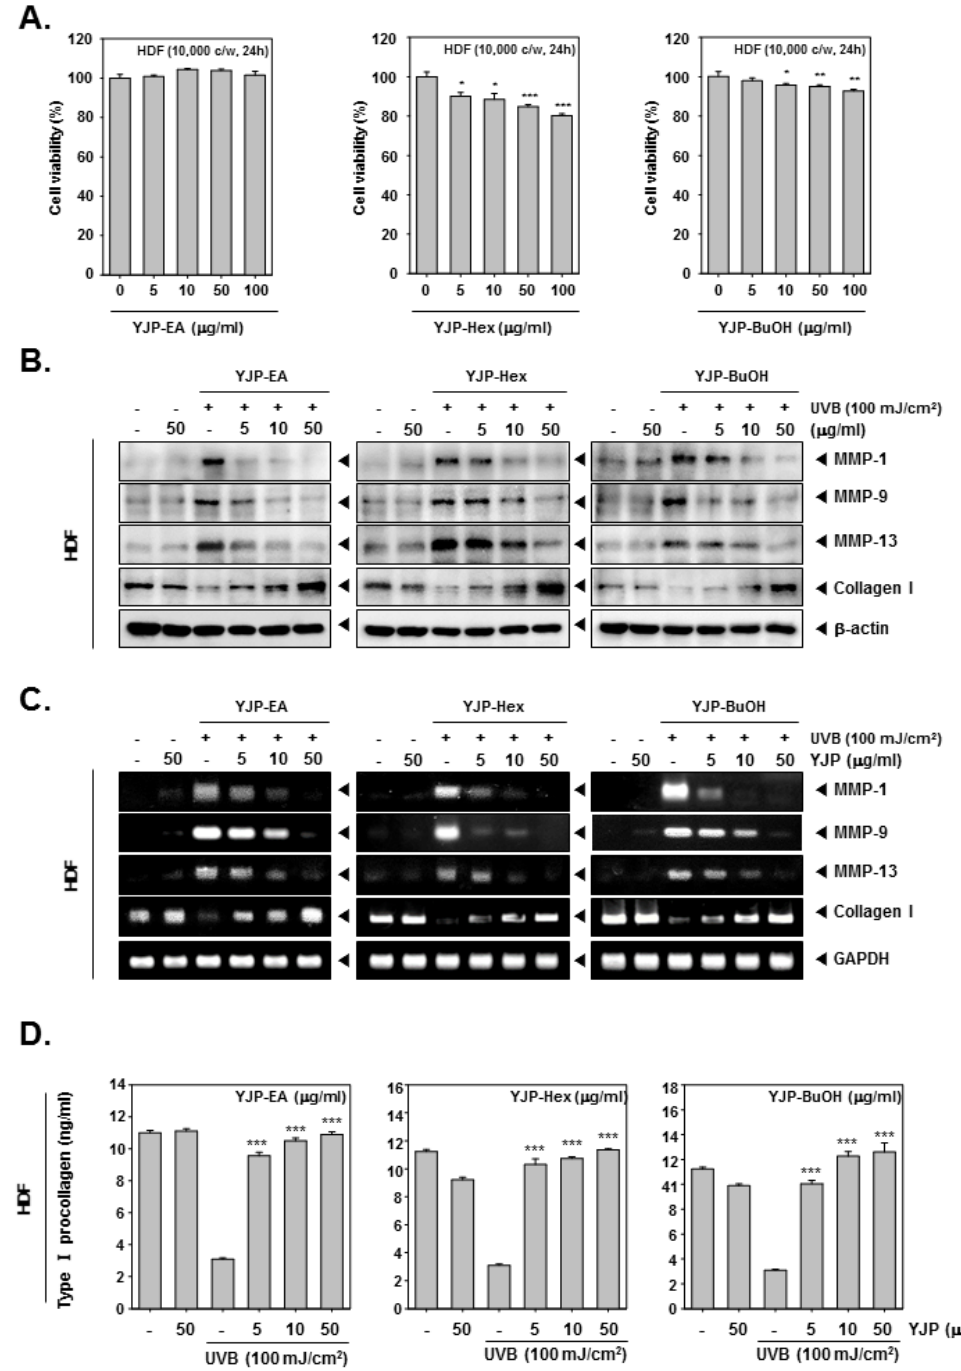
Figure 2. Anti-wrinkle effects of YJP-EA, Hex, and BuOH on UVB-irradiated human dermal fibroblast cells. ( A ) HDF cells were treated with YJP-EA, Hex, and BuOH for 24 h. An MTT assay was performed to evaluate cell viability. ( B ) HDF cells were irradiated with UVB (100 mJ/cm 2 ) and then treated with YJP-EA, Hex, and BuOH for 24 h. Whole cell lysates were analyzed by Western blot analysis. ( C ) HDF cells were treated by YJP-EA, Hex, and BuOH for 24 h after UVB (100 mJ/cm 2 ) irradiation. The RNA level was evaluated using reverse transcription PCR. ( D ) The Pro-Collagen of HDF cells was measured using an ELISA kit, following the manufacturer’s instructions, with 450 nm. All experiments were performed individually in triplicate. *** p < 0.001 vs. non-treated (NT) cells, ** p < 0.01 vs. non-treated (NT) cells, and * p < 0.05 vs. non-treated (NT)